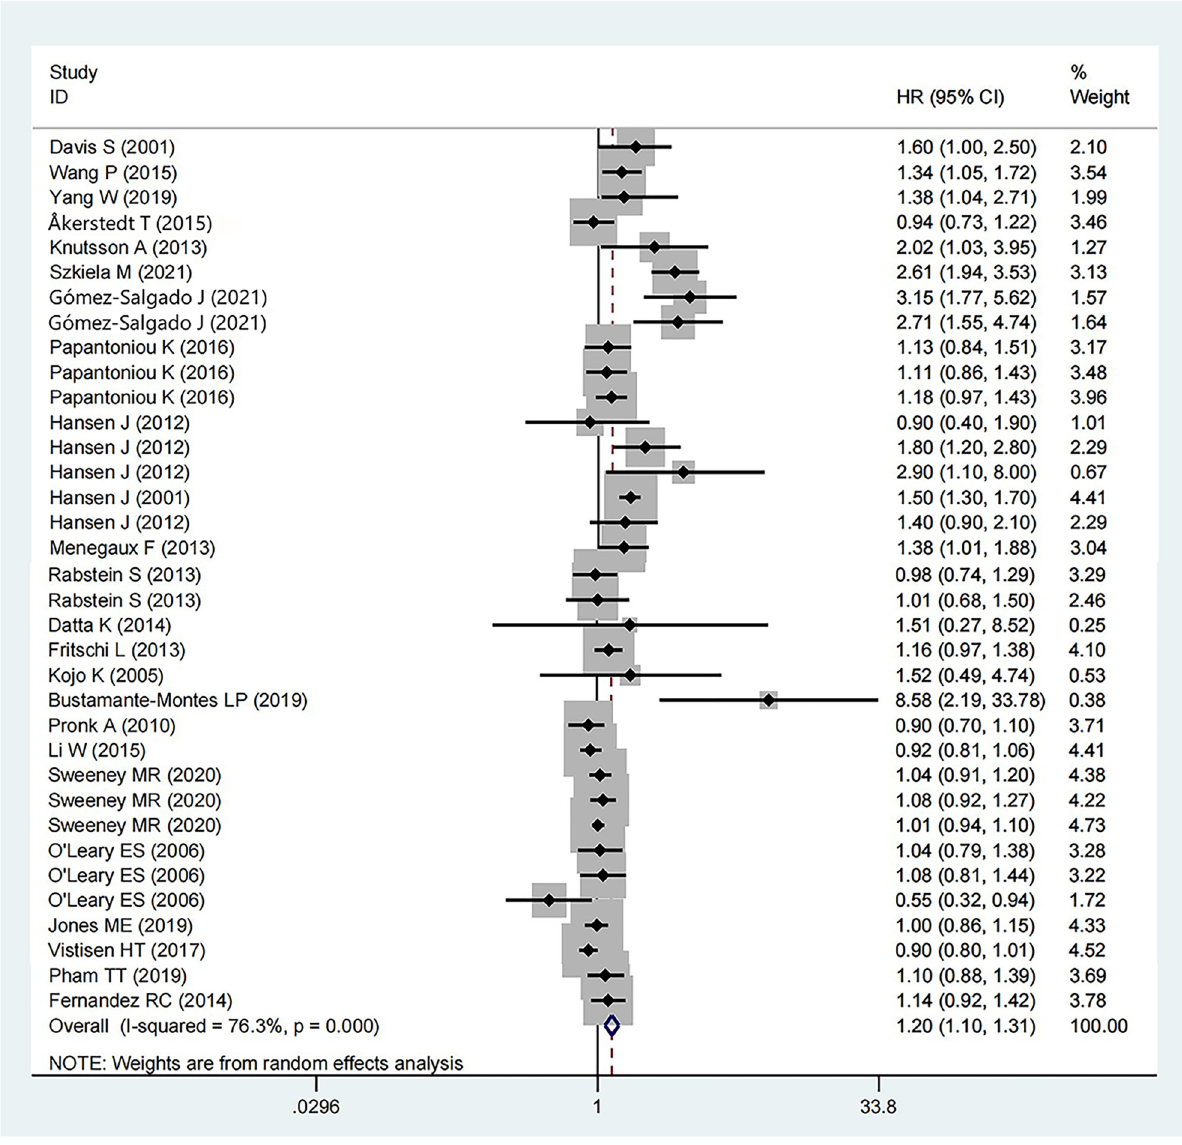
Figure 2: Forest plot describing the association between night shift work and risk of